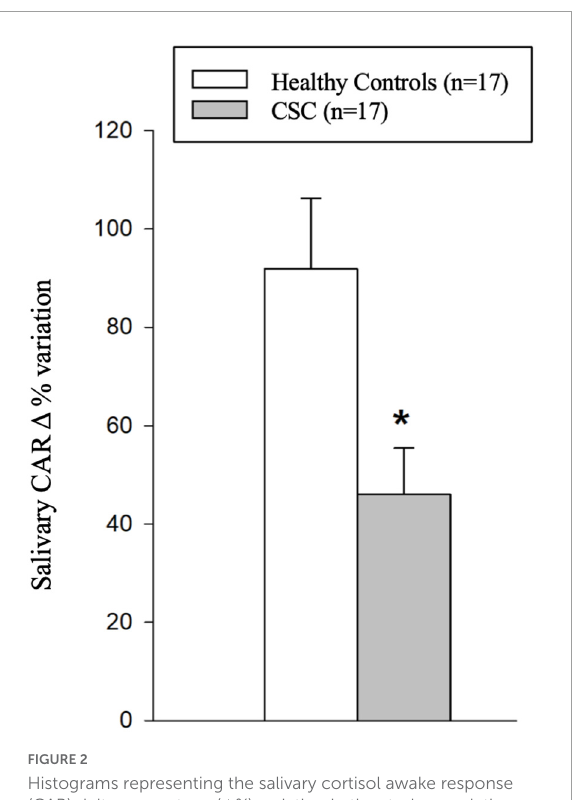
FIGURE2 Histograms representing the salivary cortisol awake response (CAR) delta percentage ( (cid:49) %) variation in the study population. Statistics: * Student’s t- test for continuous normally distributed variables: t = 2.925; p = 0.006 vs. controls.